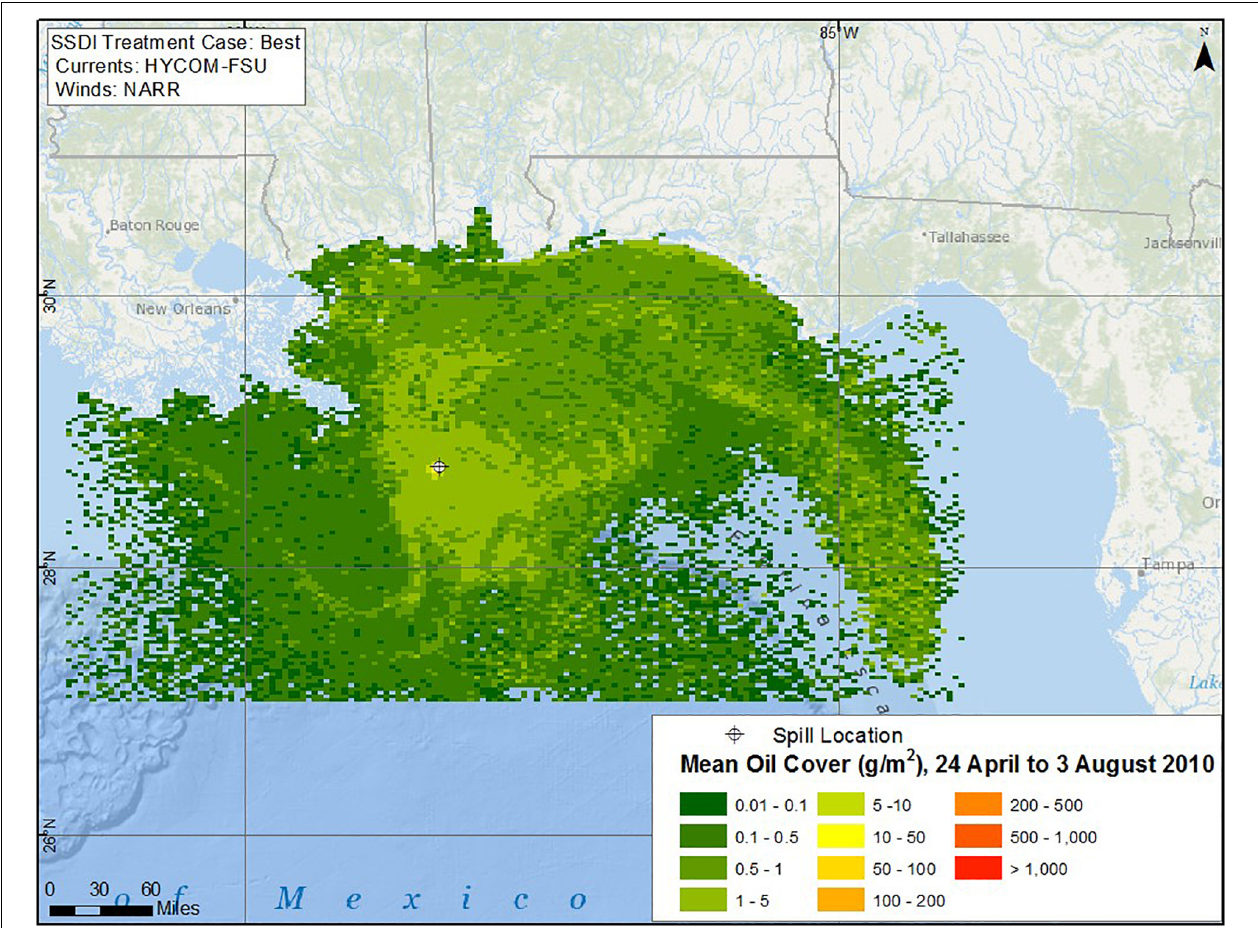
FIGURE 6 | Time-averaged mean floating oil concentration (g/m 2 ) in each cell for the period when oil was observed by SAR, 24 April to 3 August 2010, based on the base case model simulation.